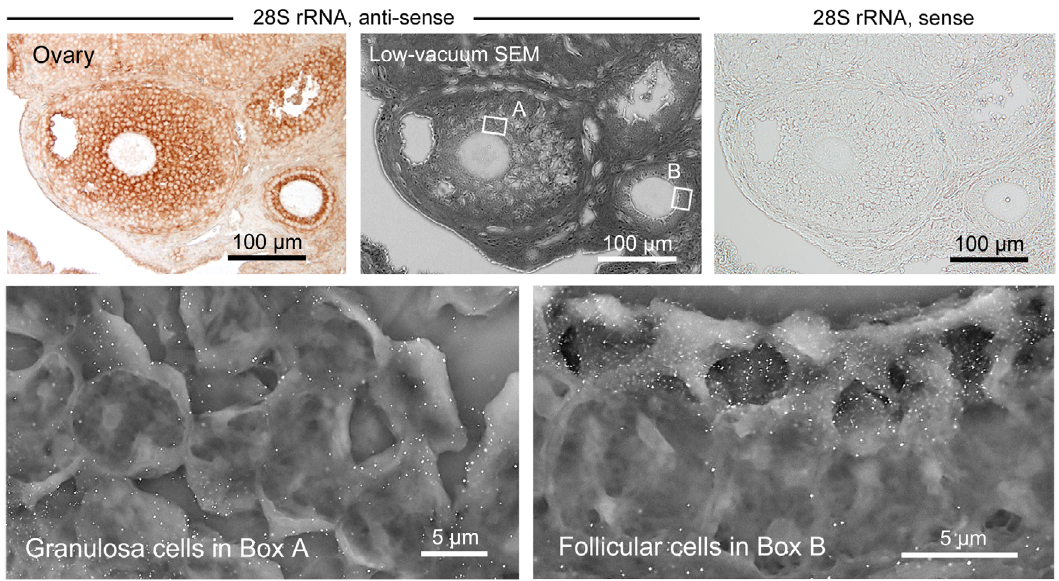
Fig. 10 Application of CLEM to in situ hybridization for gene targeting. CLEM was applied to in situ hybridization for gene targeting of 28 S rRNA on the mouse ovary. Note the intense nanogold labeling on the granulosa cells in Box A and the apical region of the follicular cells in Box B. The 28 S rRNA sense probe, as a negative control, showed no